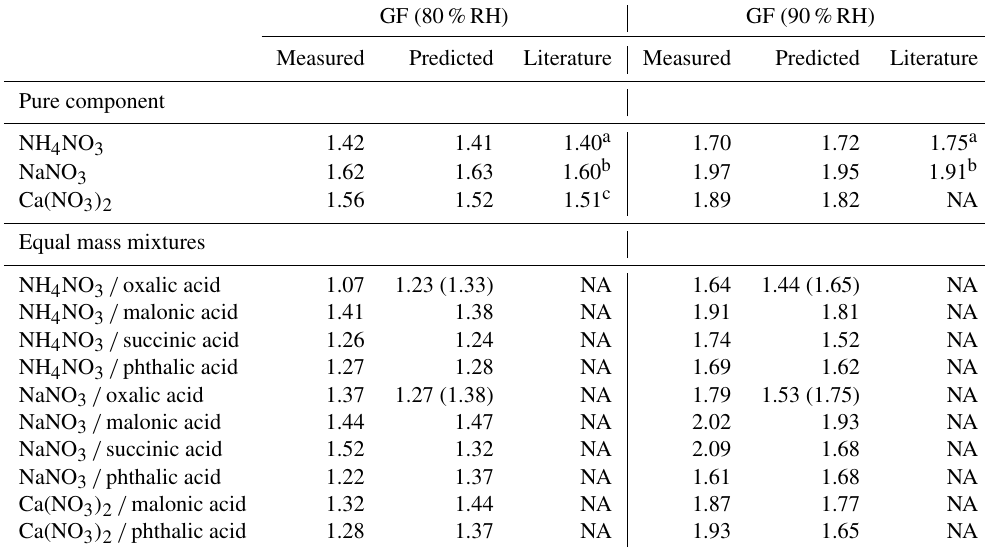
Table 2. Hygroscopic growth factors of nitrate-salt-containing particles in this study. The predictions for pure components and mixtures are from the AIOMFAC model and the ZSR relation, respectively. For oxalic-acid-containing mixtures, the predicted values based on measure- ments from Mikhailov et al. (2009) are shown in brackets.